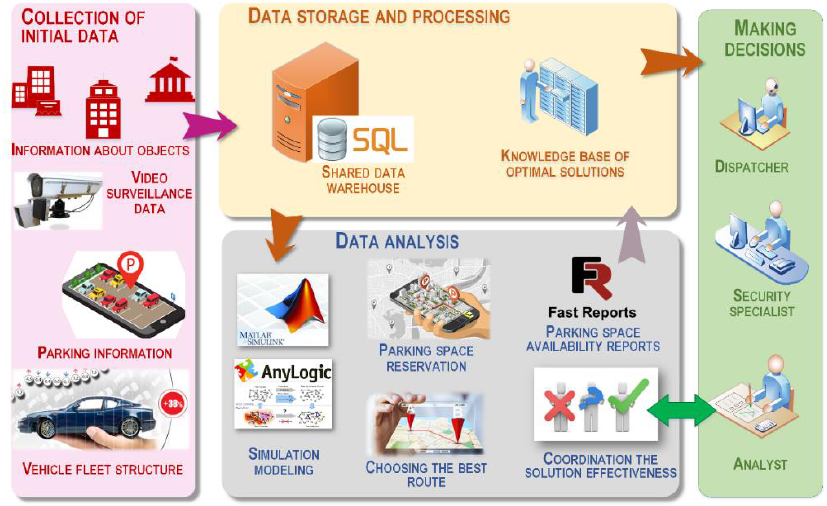
Figure 1. Conceptual structure of the DSS (drawn by authors).